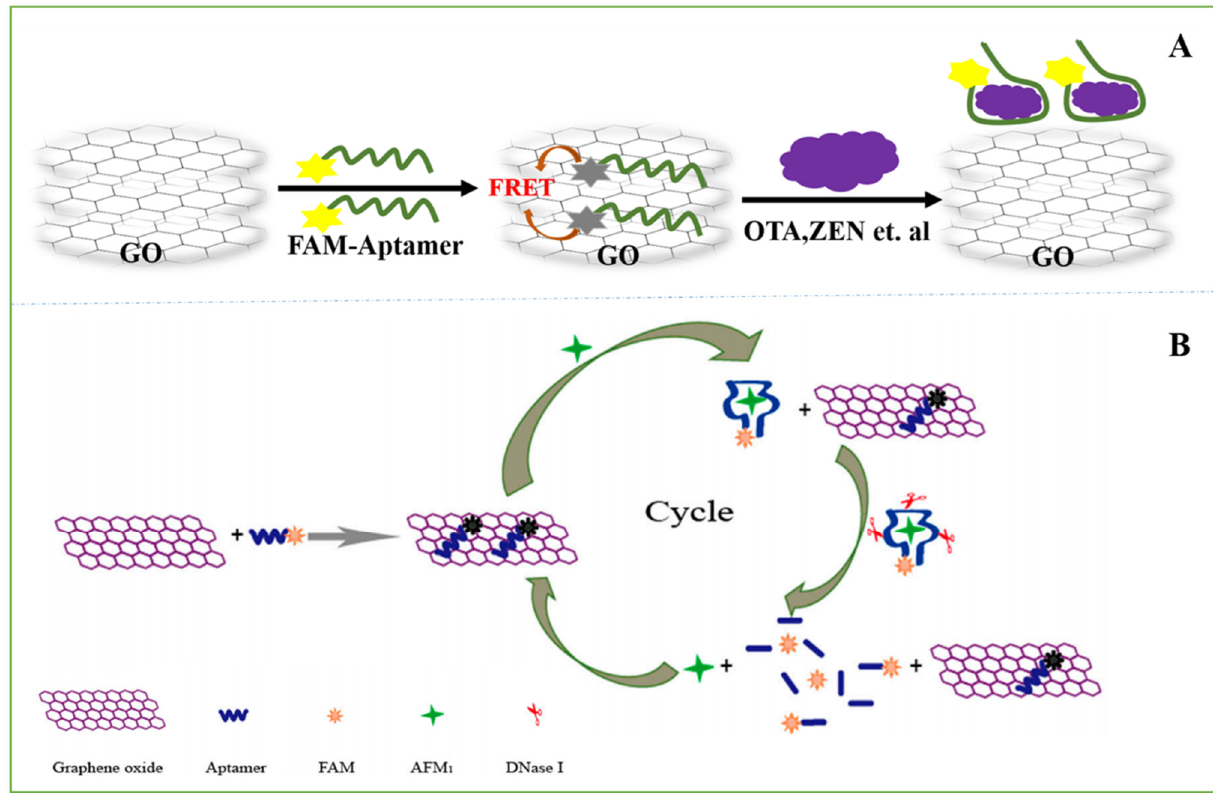
Figure 5. ( A ) Schematic diagram of an aptamer for detection of mycotoxins based on FRET. ( B ) Illustration of the aptasensor for the detection of aflatoxinM1(AFM1). FAM: carboxyfluorescein [115]. Reprinted from MDPI, 2019.